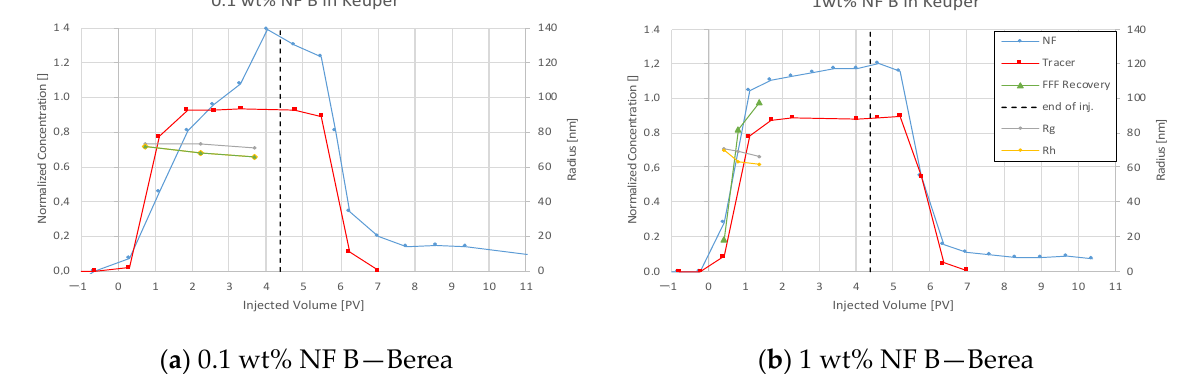
Figure 13. Effluent analysis for NF B in for 0.1 wt% ( a ) and 1 wt% ( b ) in TW in Keuper sandstone. Effluent analysis for nanofluid (NF) B in Keuper shows concentration peaks exceeding the injected concentration. In both cases, the calculated concentration remains at a constant level after the injection. The maximum measured NF concentration was 0.14 and 1.2 wt%, exceeding the respective injection concentration. The concentration does not reduce completely to zero after the injection and stays at ~12% in both cases.